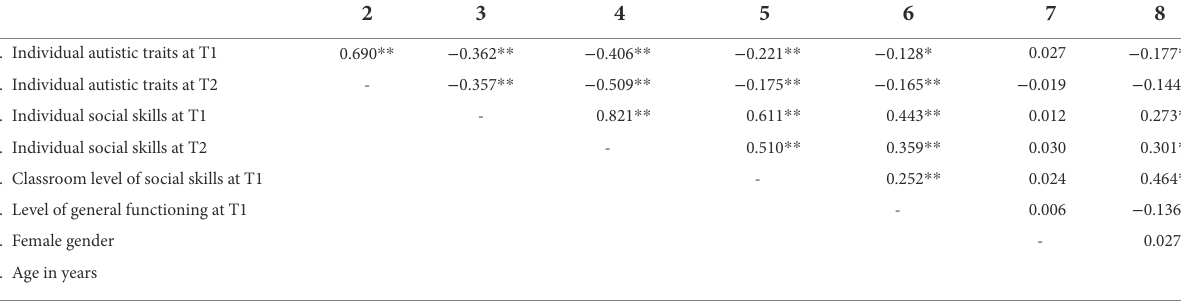
TABLE 2 Correlations between the main study variables ( N total =